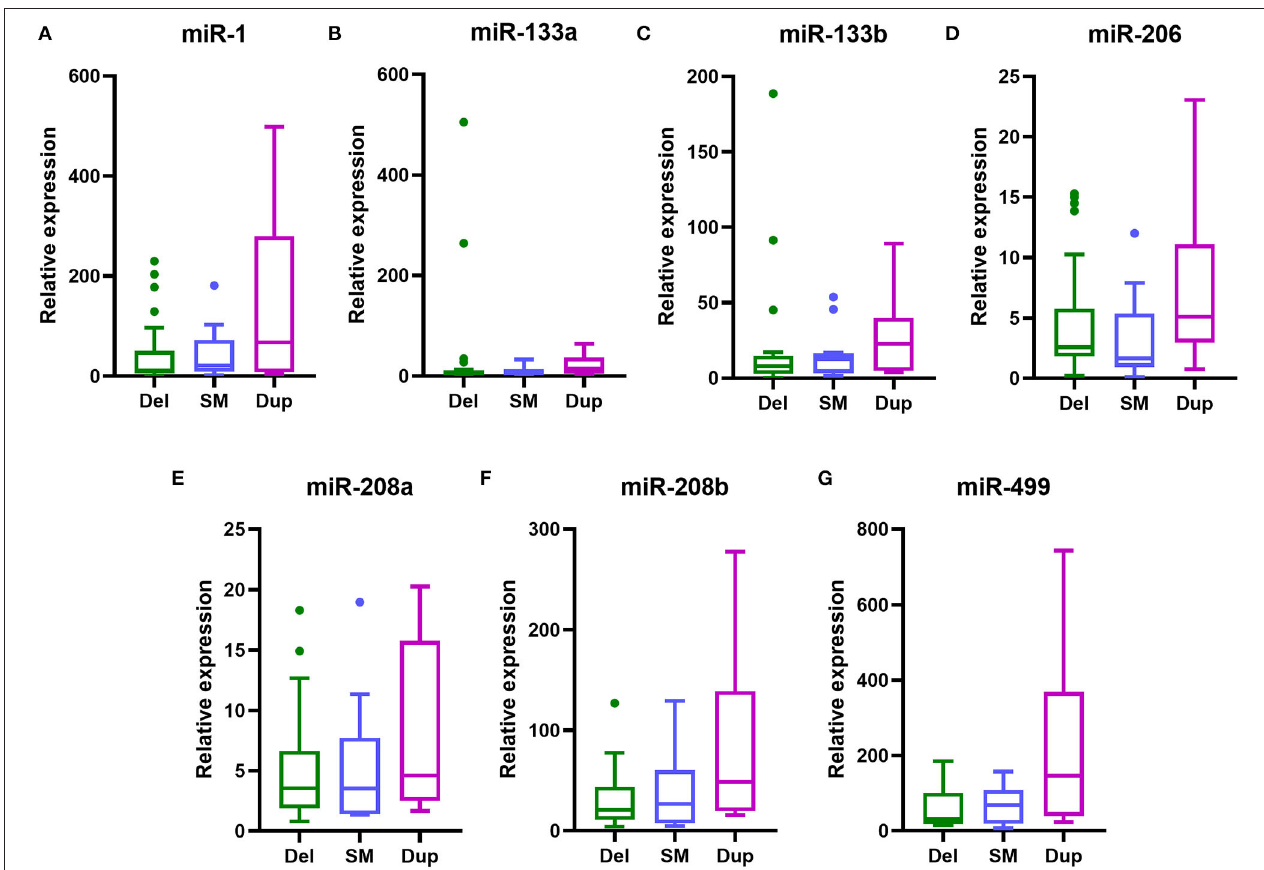
FIGURE 4 | Serum levels of myomiRs with different genotypes of DMD mutations. Serum levels of myomiRs, (A) miR-1, (B) miR-133a, (C) miR-133b, (D) miR-206, (E) miR-208a, (F) miR-208b and (G) miR-499, of the 48 DMD patients divided into three groups (green for Del, n = 27; light blue for SM, n = 13; purple for Dup, n = 8) are shown as Tukey box plots. The lines in the boxes indicate the median levels, the box limits indicate first and third quartiles, the highest line means the Q3 + 1.5 IQR, lowest line means Q1 – 1.5 IQR, and individual points represent outliers. As data of the three groups were non-normally distributed variables, the non-parametric Kruskal–Wallis test was used for multiple comparison. Del, deletion; SM, small mutation; Dup,